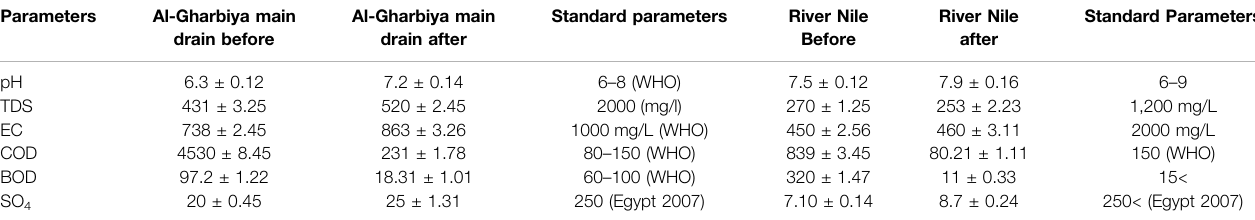
TABLE 3 | Physiochemical parameters of the drainage and fresh water before and after treatment with ZnO(nano)/H 2 O 2 /UV.